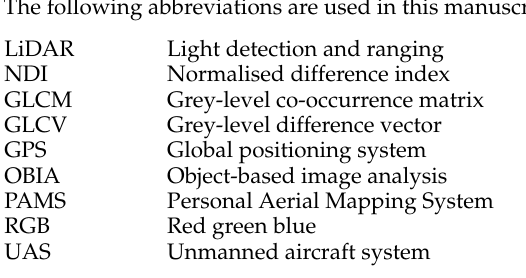
Figure S1: Classification scheme for the manual mapping, Table S1: Error matrices for all sites at all levels of